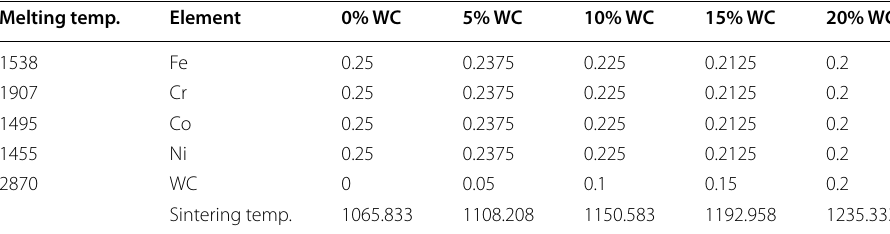
Table 1 Calculation of sintering temperature of HEA Melting temp.